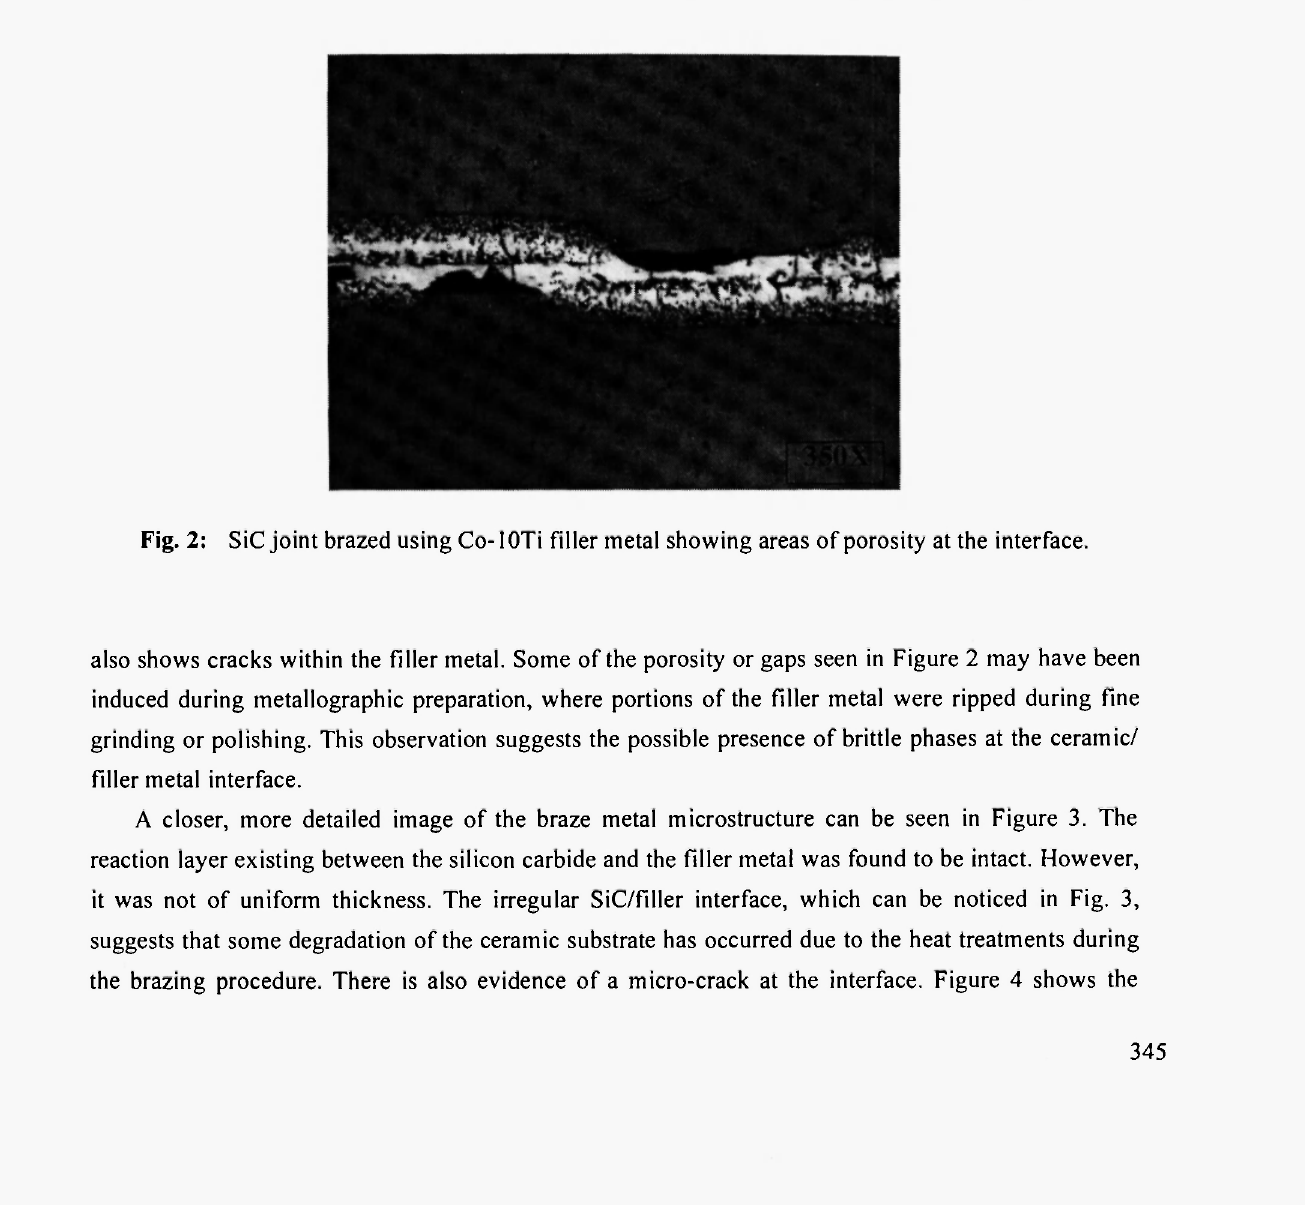
Fig. 1: SiC joint brazed using Co-lOTi filler metal at 1300°C in vacuum for 15 minutes.